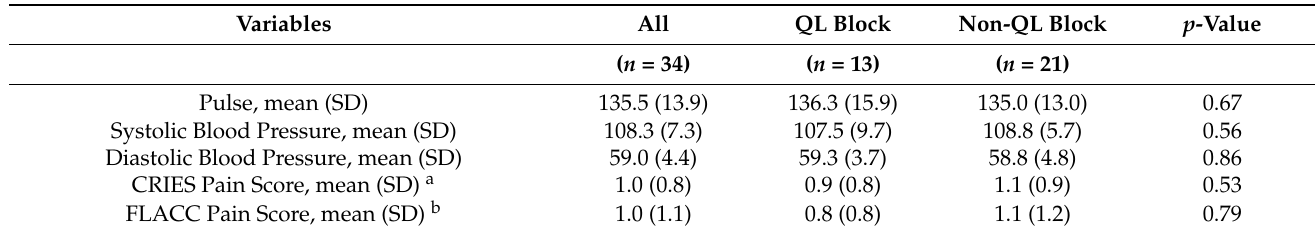
Table 3. Pain Criteria and Hemodynamic Variables ( n =